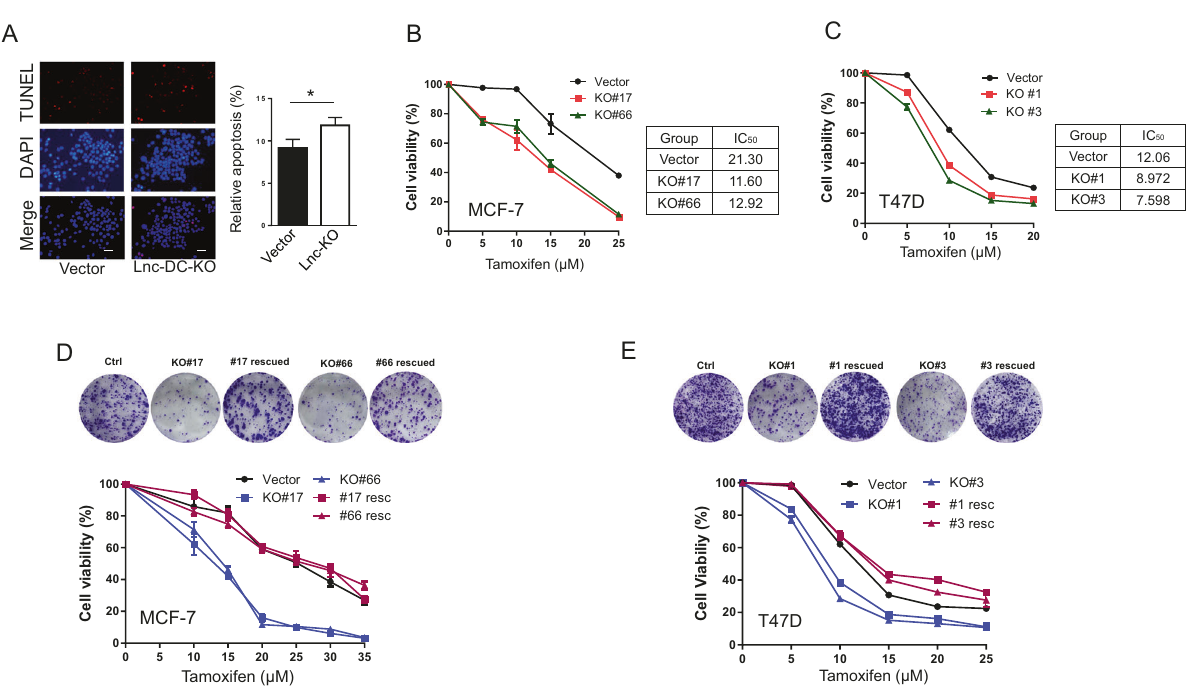
Fig. 3 Determination of Lnc-DC-mediated tamoxifen resistance by Lnc-DC KO and rescue assays. A Lnc-DC KO increases tamoxifen- induced apoptosis, as detected by TUNEL assays. B , C Lnc-DC KO cells (MCF-7 and T47D) have a low IC50 in response to tamoxifen, as determined by colony formation assays. The cells were treated with indicated concentrations of tamoxifen, and colonies were countered 2 weeks after the treatment. D , E Re-expression of Lnc-DC in KO cell restores the response to tamoxifen as vector control in both MCF-7 and T47D cells, as determined by colony formation assays. Values are mean ± SD ( n = 3). * p < 0.05; bar, 10